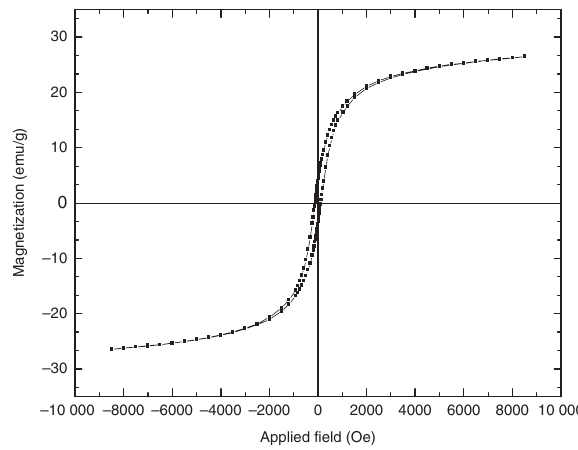
O by citric acid at 850 ° C. 12 19